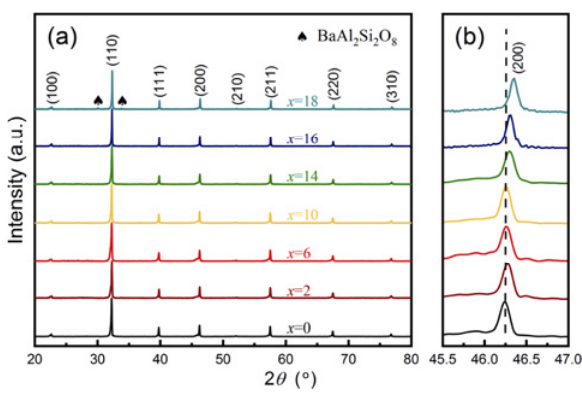
Fig. 1 (a) XRD patterns of BS 0.5 BNT– x GS ceramic composites ( x = 0, 2, 6, 10, 14, 16, and 18) in the range of 2 θ = 20°–80° and (b) enlarged view of (200) diffraction peaks in the range of θ = 45.5°–47°.